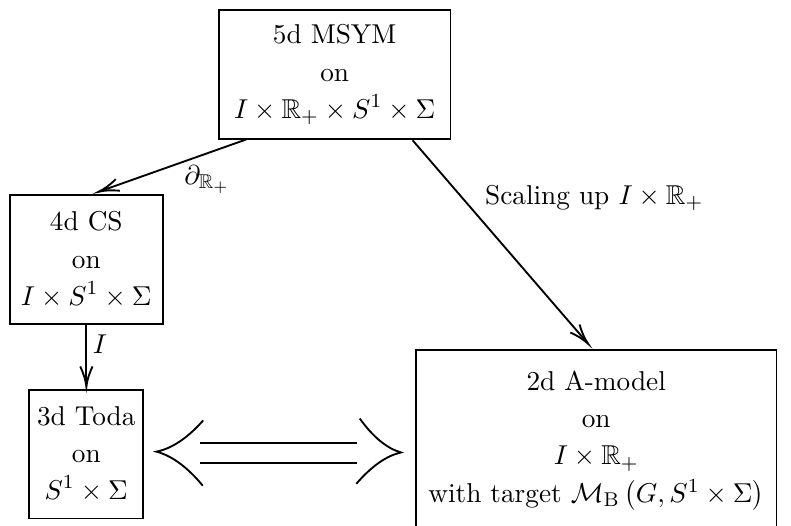
Figure 1 . Outline of the steps in this paper. Starting from “GL”-twisted 5d MSYM, we are able to establish a novel correspondence between the 3d Toda theory and a 2d A-twisted sigma model (cid:0) (cid:1) governing maps I × R + → M B G, S 1 × Σ .